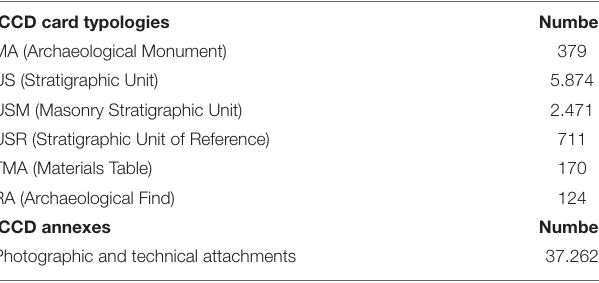
TABLE 3 | Representation of the ICCD cards belonging to the “Scavo Piazza Municipio” domain.